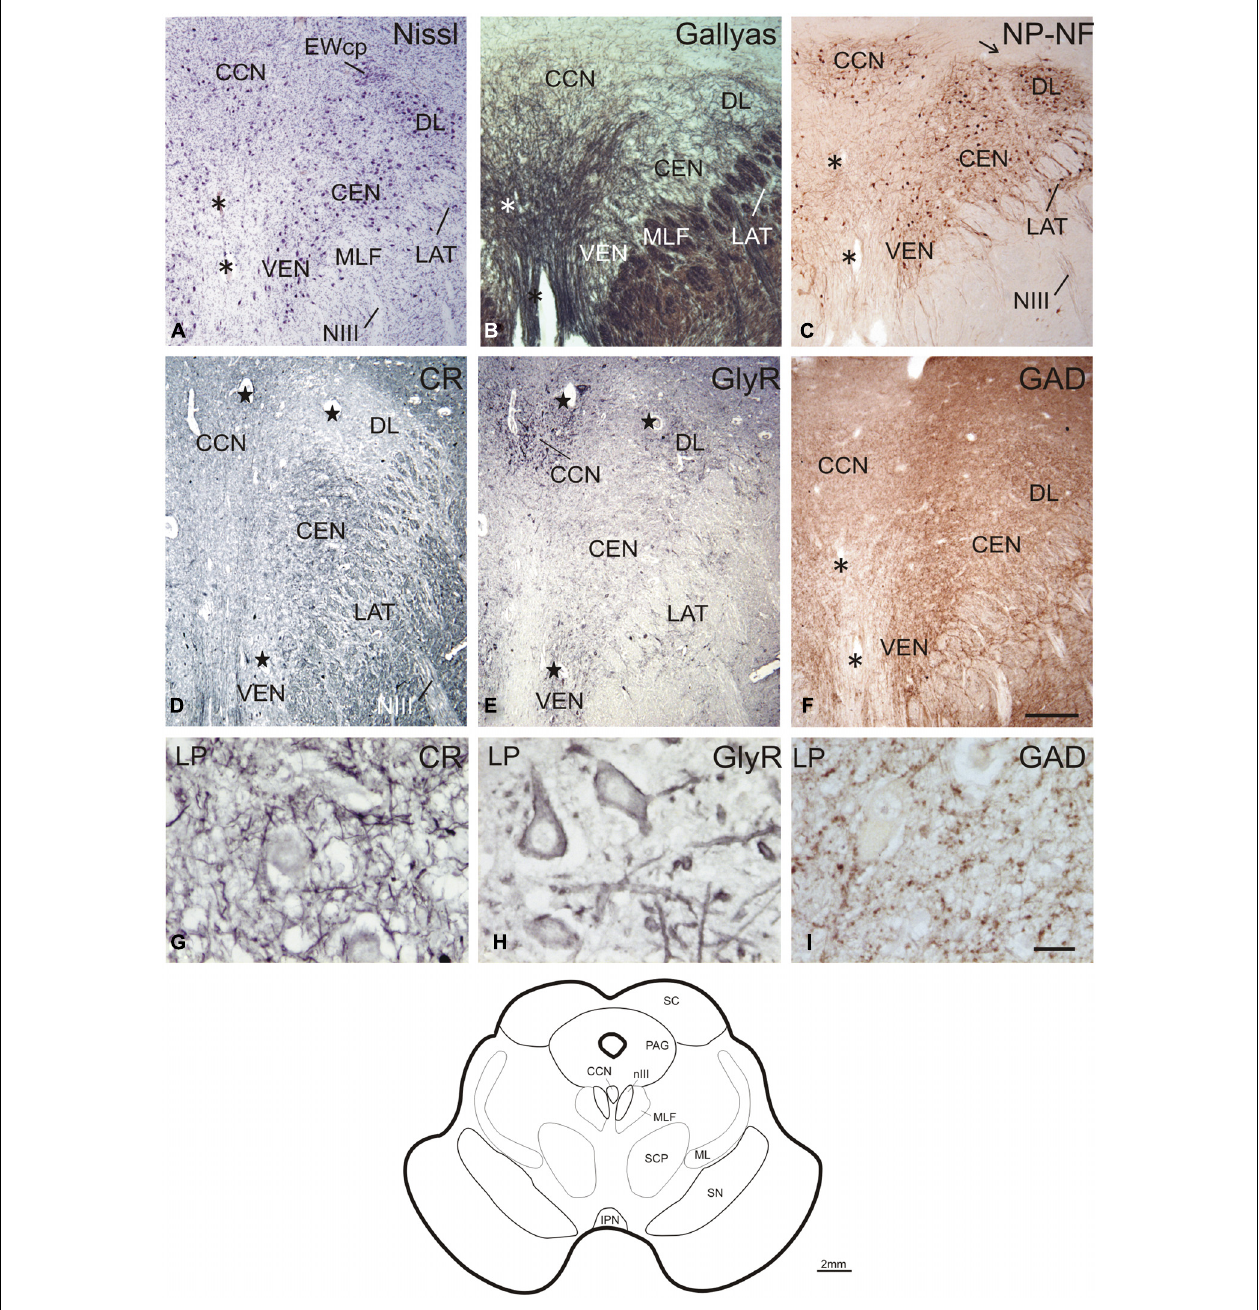
FIGURE 2 |Transverse sections through the caudal plane of the oculomotor nucleus (nIII). Cresyl violet (A) , Gallyas fiber staining (B) , and immunostaining for non-phosphorylated neurofilaments (NP-NF) (C) reveal several subnuclei of the oculomotor nucleus complex that exhibit different staining patterns for calretinin (CR) (D) , glycine receptor (GlyR) (E) , and glutamate decarboxylase (GAD) (F) . The central caudal nucleus (CCN) appears as a separate nucleus embedded in the medially descending fibers (A–C) . The CCN is high-lighted by its GlyR expression (E) and shows a moderate supply by CR- and GAD-positive profiles (D,F) . A dorsolateral group (DL) of nIII is separated by encircling fibers (A–C) . DL is devoid of CR-positive profiles (D) , but rich in GlyR- and GAD-positive profiles (E,F) . A similar pattern is seen for the ventral group (VEN) and lateral group (LAT), which forms an island of cells within the medial longitudinal fascicle (MLF)